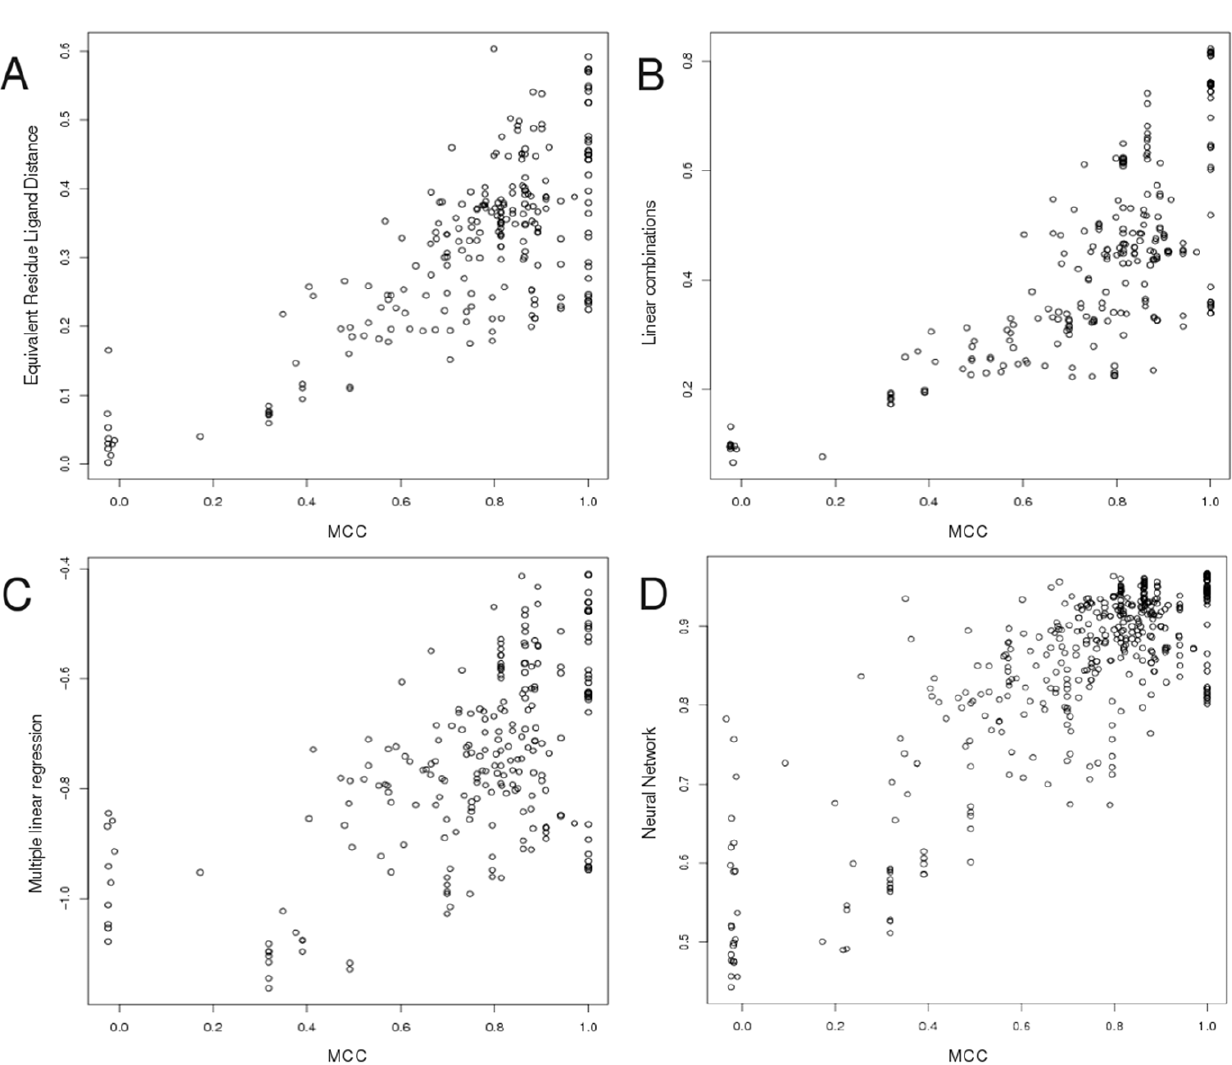
Table 2. The Multiple Linear Regression score results in a